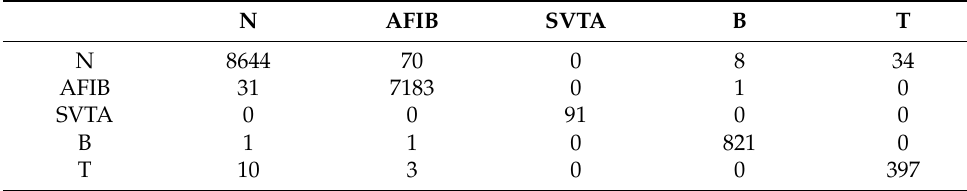
Table 4. Confusion matrix of the proposed approach for ECG rhythms with few samples.